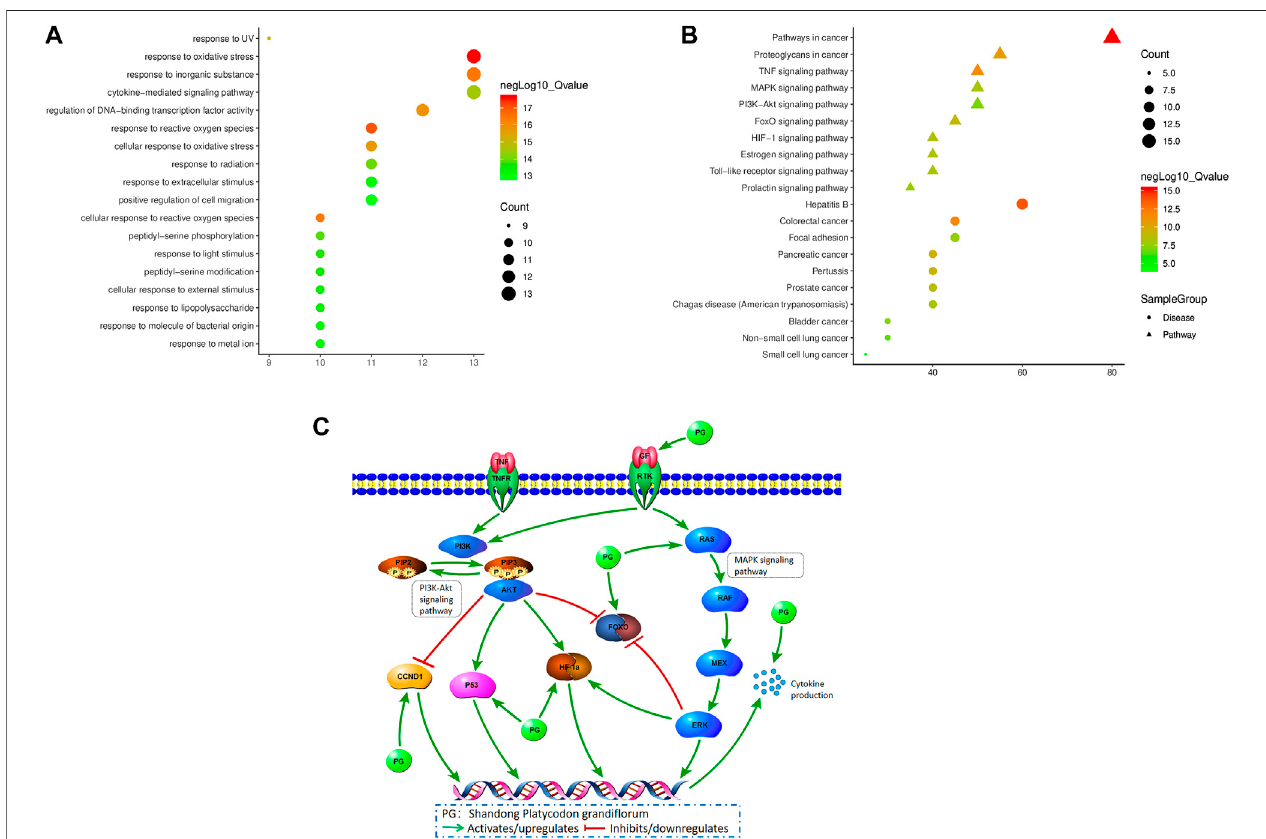
FIGURE 9 | (A) Bubble chart of GO function enrichment of core targets (B) Bubble chart of KEGG enrichment of core targets (C) Potential mechanisms of Platycodon grandi fl orum treatment for lung cancer.